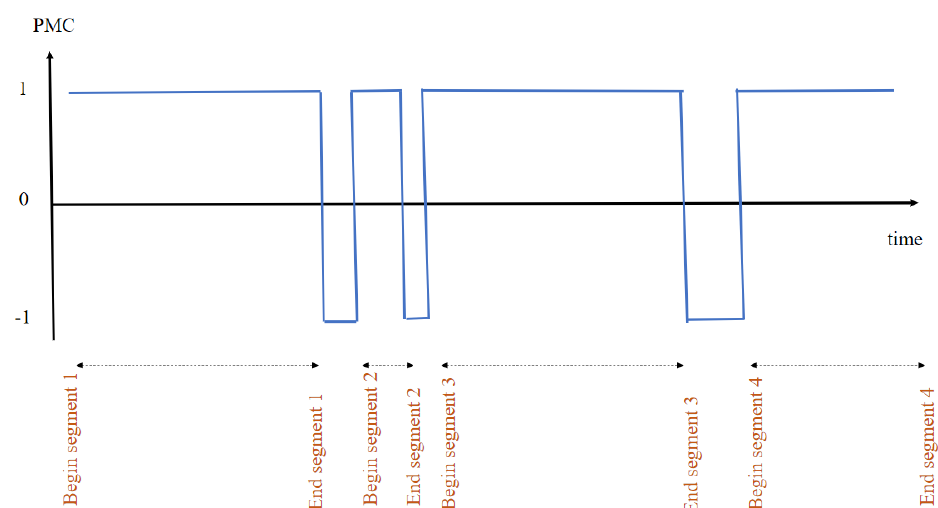
Figure 2. Real-time human activity recognition